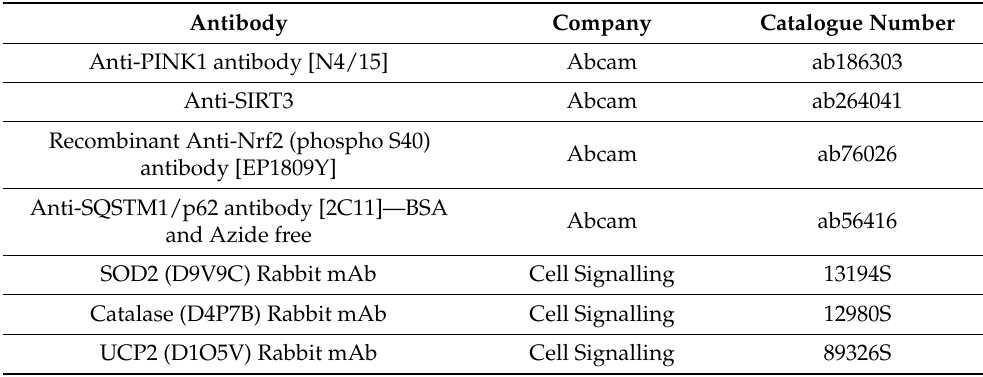
Table 1. Antibodies used for